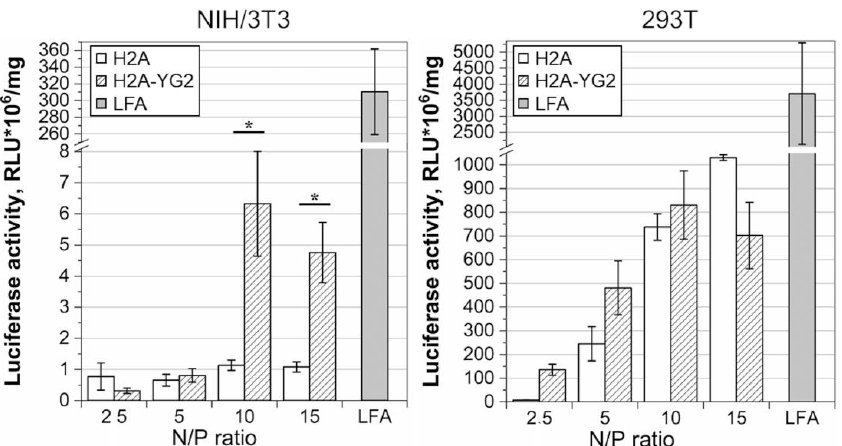
Figure 4. Luciferase activity in the transfected cell lines. Luciferase activity in the lysates of NIH / 3T3 (Pdgfr β -positive) and HEK 293T (PDGFR β -negative) cells after transfection with Lipofectamine ® 2000 (LFA) and histones H2A and H2A-YG2 in N / P ratios 2.5, 5, 10, and 15 using pCMV_EGFP_P2A_luc2 is shown. Mean values (n = 6) are shown, error bars represent standard error (n = 6); * p < 0.05.